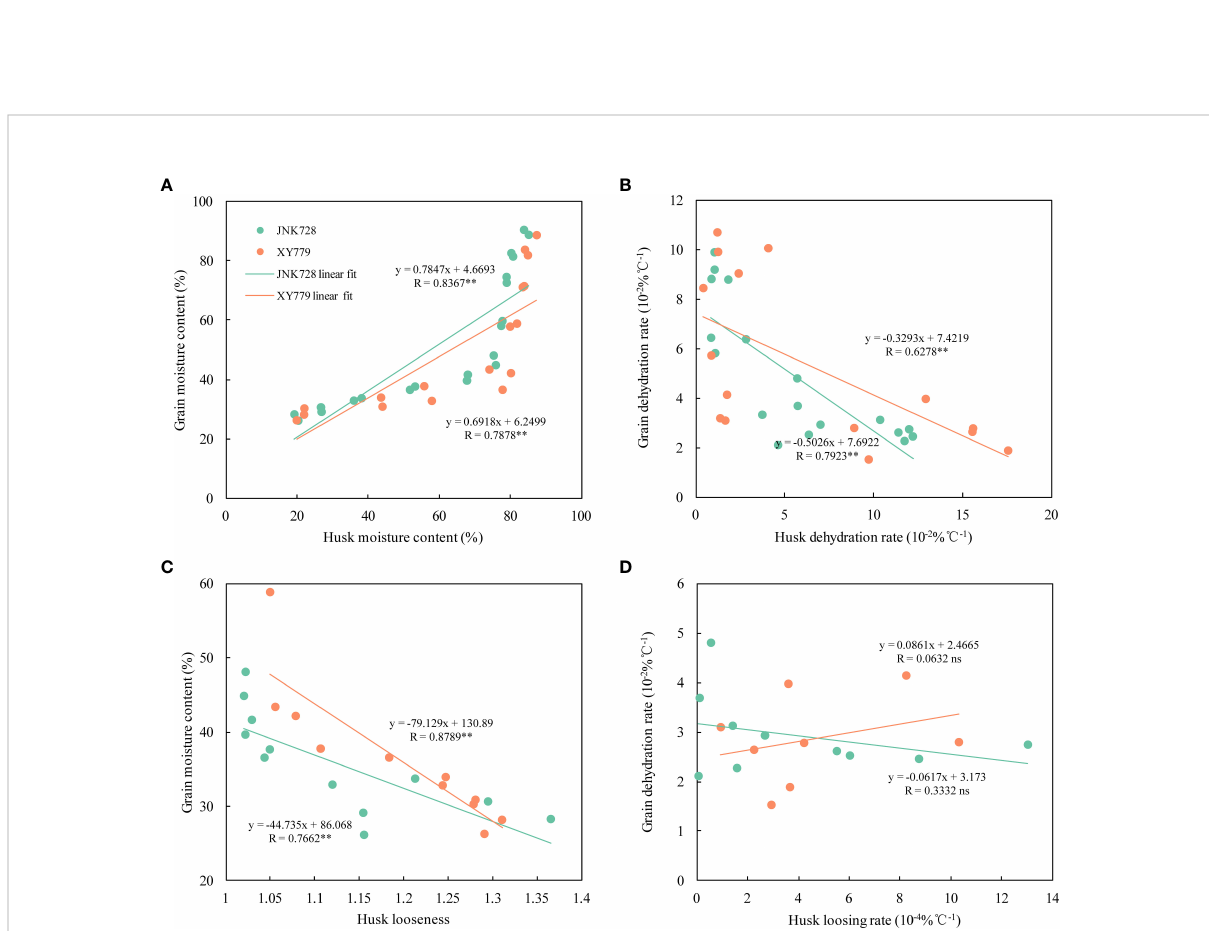
FIGURE 13 (A) Correlation analysis between the grain and husk moisture content, (B) the grain and husk dehydrating rate, (C) the grain moisture content and husk looseness, and (D) the grain dehydration rate and husk loosing rate of JNK728 and XY779 at the grain fi lling stage in 2021 and 2022. The double asterisks “ ** ” indicate signi fi cance at the 0.01 probability level, while “ ns ” represents no signi fi cance.